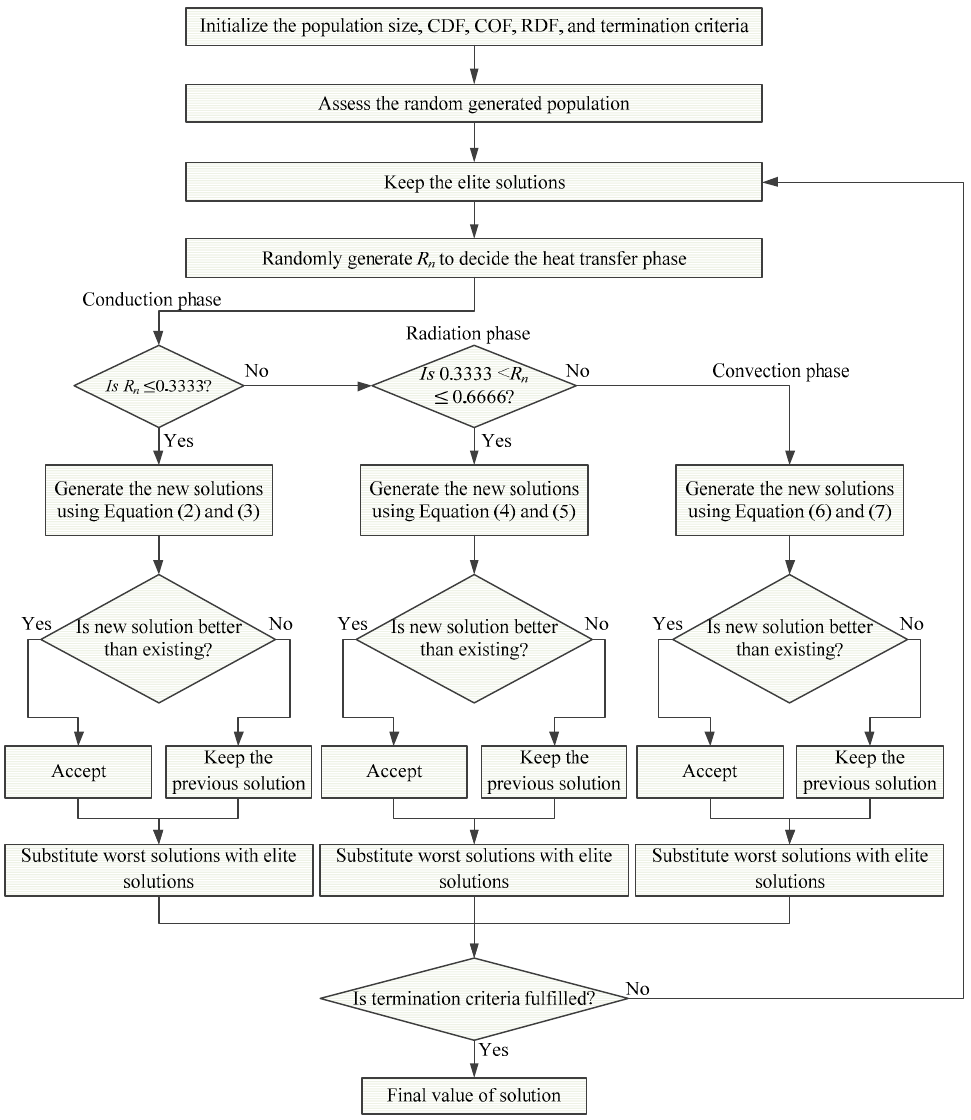
Figure 1. Flowchart of the heat transfer search (HTS) algorithm. CDF; conduction factor, COF: convection factor, RDF: radiation factor, and R n : random variable.